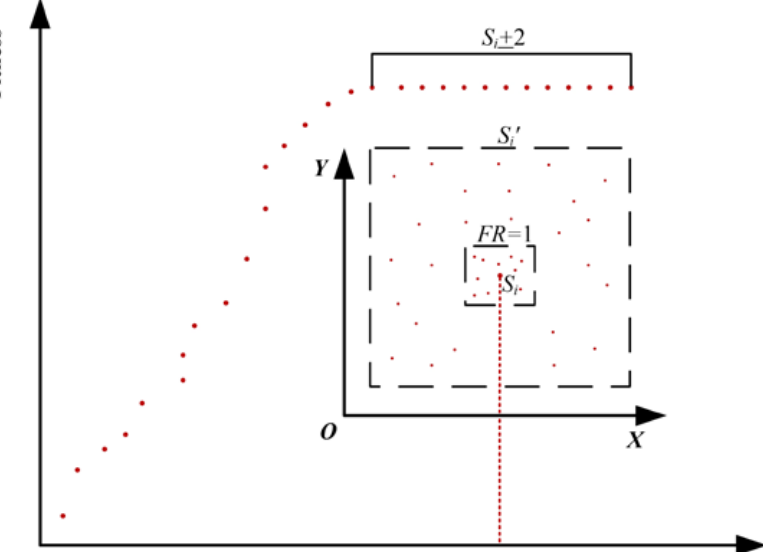
Figure 2. Flowchart of the IFOA.